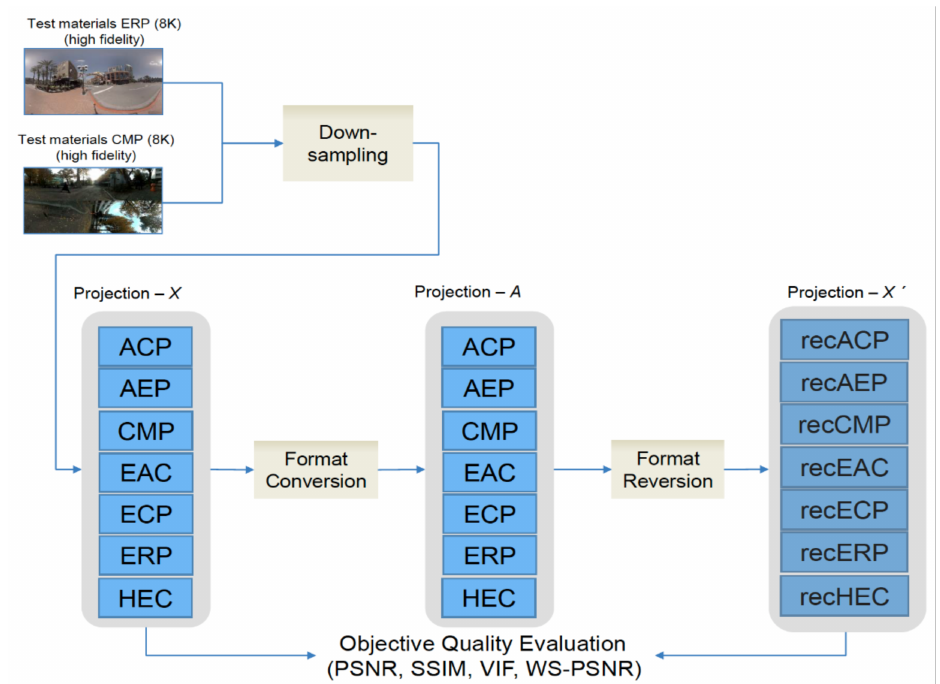
Figure 2. Proposed framework for the evaluation of projection formats. Projection– A can be any projection except Projection– X . Projection– X ’ means reconverted projection format of Projection– X from Projection– A